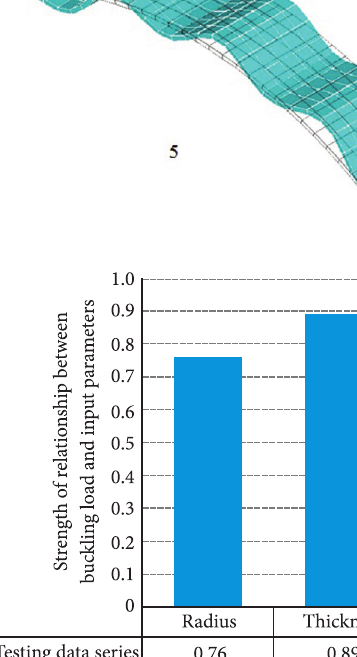
Fig. 6. The sensitivity analysis of the buckling load and each input